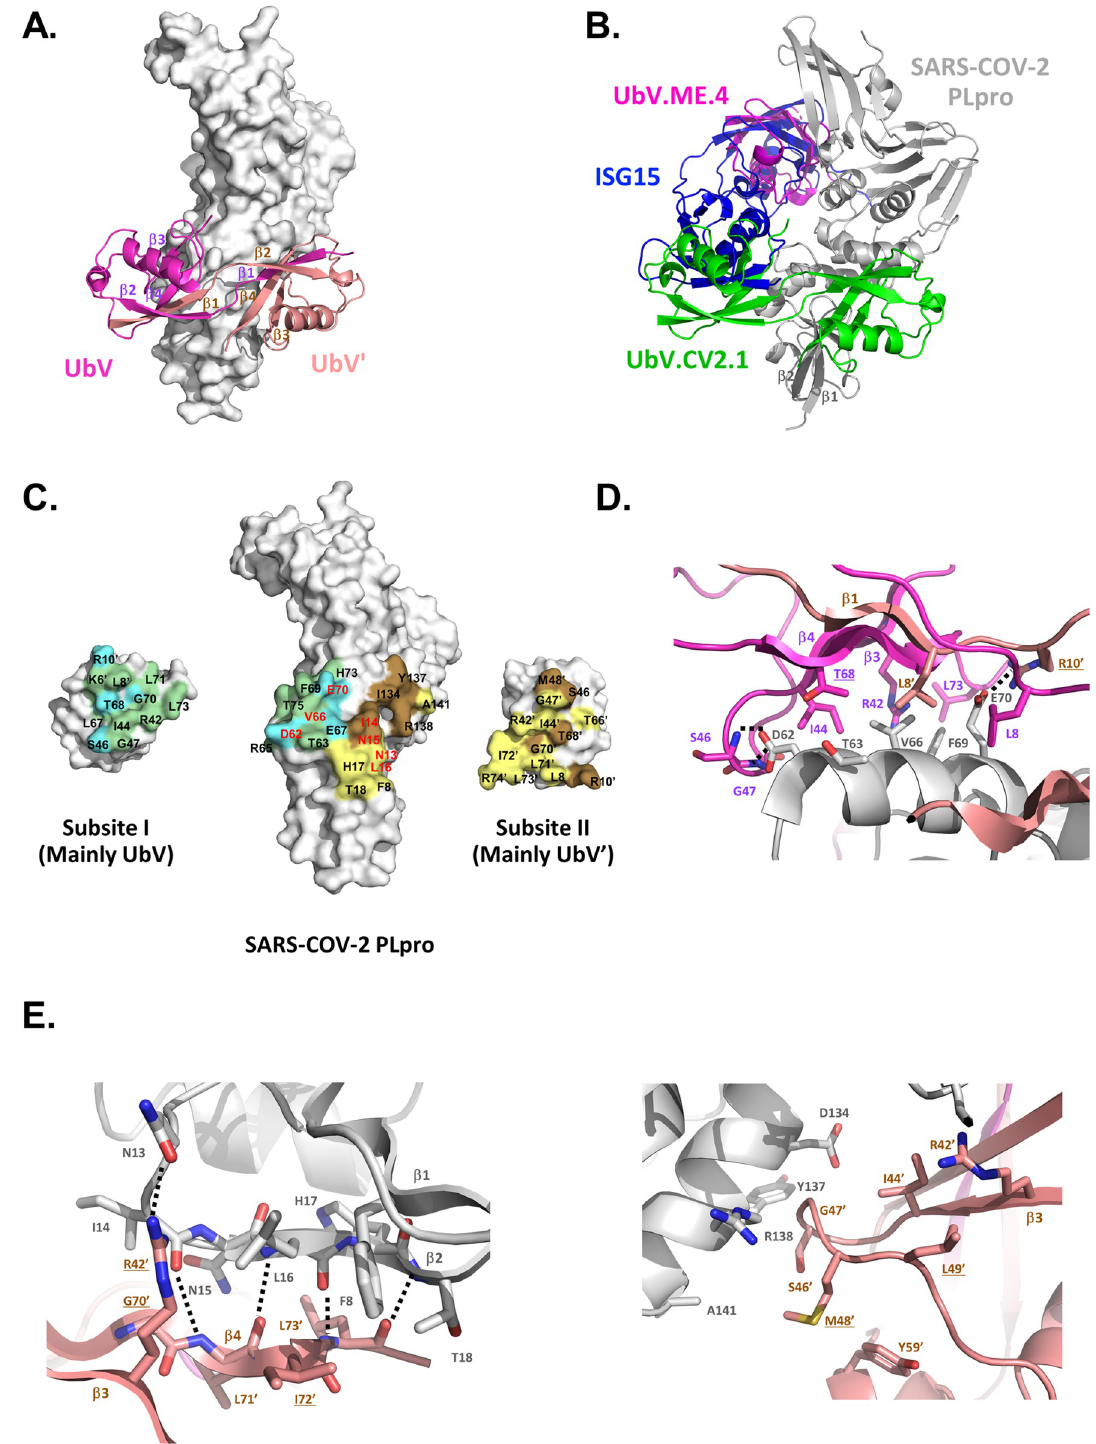
Fig 5. Structure of the SARS-CoV-2 PLpro bound to a UbV.CV2.1. dimer. . (A) Overall structure of the complex. PLpro is represented as a white molecular surface, and the UbV.CV2.1 dimer is represented as a ribbon with the promoters colored magenta (UbV) or salmon (UbV’). (B) Superposition of the SARS-CoV-2 PLpro (grey) in complex with the UbV.CV2.1 dimer (green) with the structure of ISG15 (blue) from the complex with the SARS-CoV-2 PLpro (PDB entry 6YVA), and the structure of UbV.ME4 monomer (magenta) from the complex with the MERS PLpro (PDB entry 5V69). (C) Open-book view of the complex. SARS-CoV-2 PLpro is